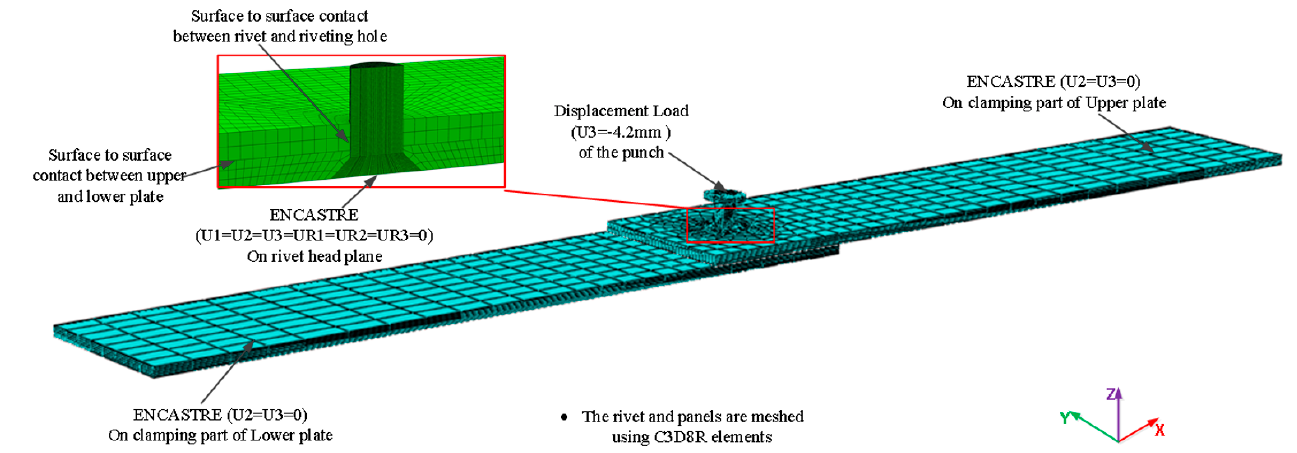
Figure 3. Riveting model after finite element meshing.